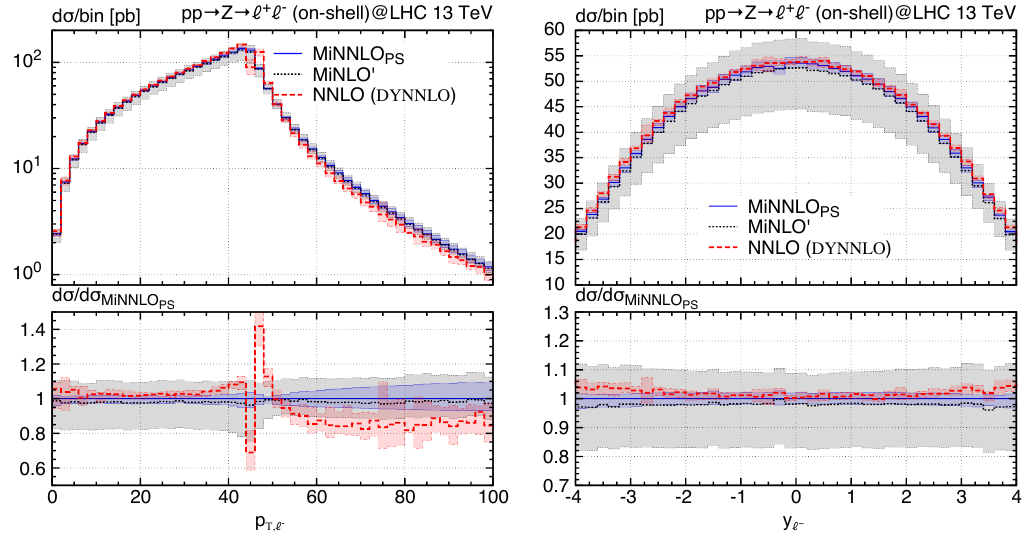
Figure 5 . Distribution in the transverse momentum (left) and rapidity (right) of the negatively charged lepton for MiNNLO PS (blue, solid), MiNLO 0 (black, dotted), and NNLO (red,